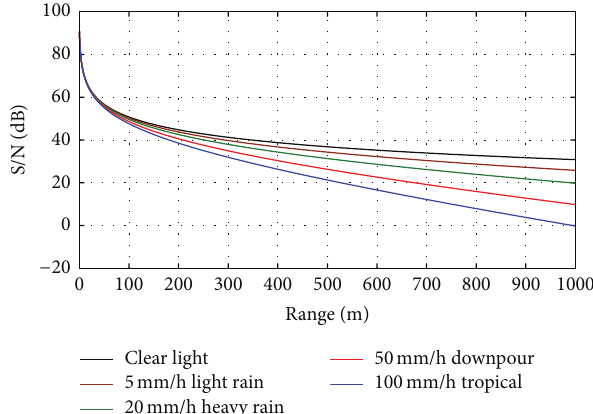
Figure 11: Link S/N versus distance for different rain conditions (32 × 32